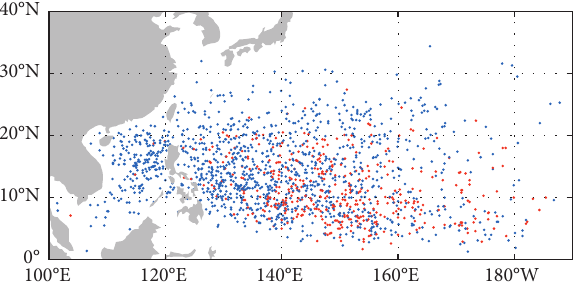
Figure 1: Spatial distribution of genesis positions of all TCs over the WNP. Blue dots denote the genesis positions of TCs with intensities reaching TS, and red dots denote the genesis positions of C45 TCs.